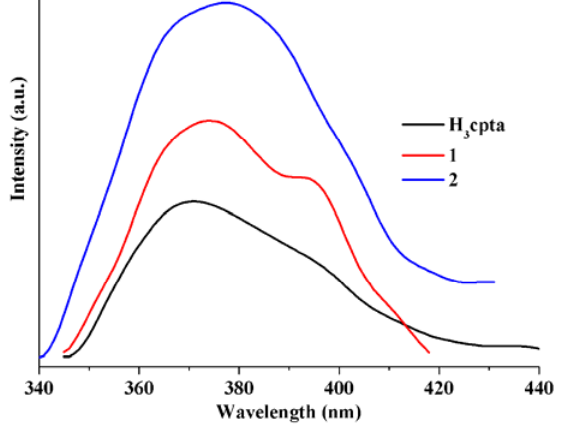
Figure 3. Solid-state emission spectra of H 3 cpta, CP 1 and MOF 2 at room temperature; λ ex is 320 (H 3 cpta), 318 ( 1 ), or 348 nm ( 2 )).